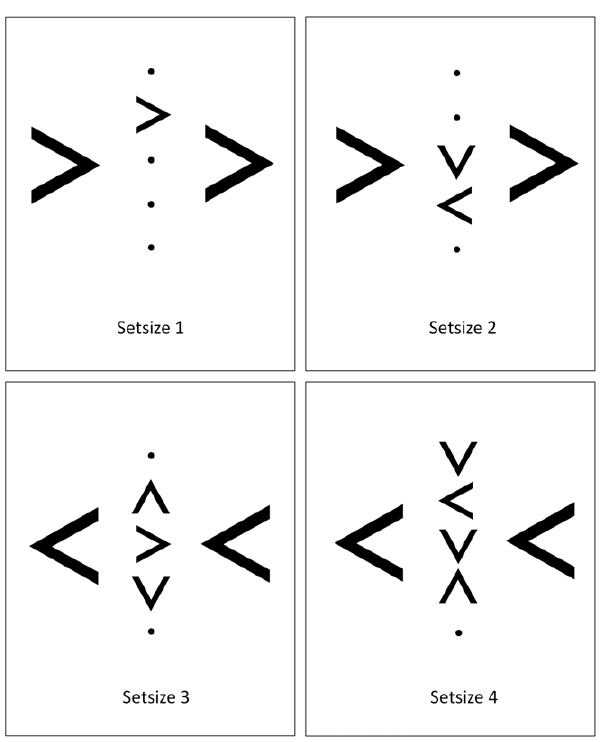
Figure 1. Examples of the stimulus displays for each condition of perceptual load in Experiment 1. Top left and bottom right panels are compatible displays, top right and bottom left panels are incompatible displays. Images not to